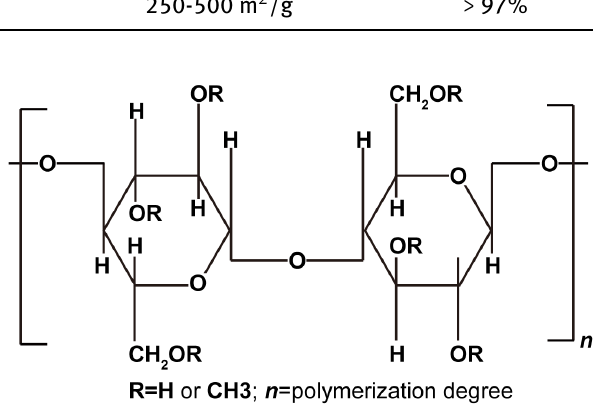
Figure 1: The chemical elements and structure of